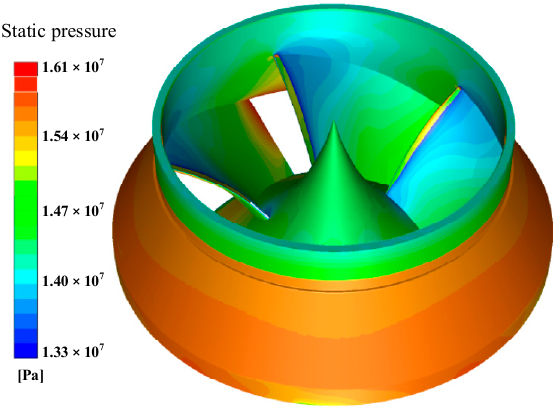
Figure 4. The map of static pressure distribution on the impeller surface.